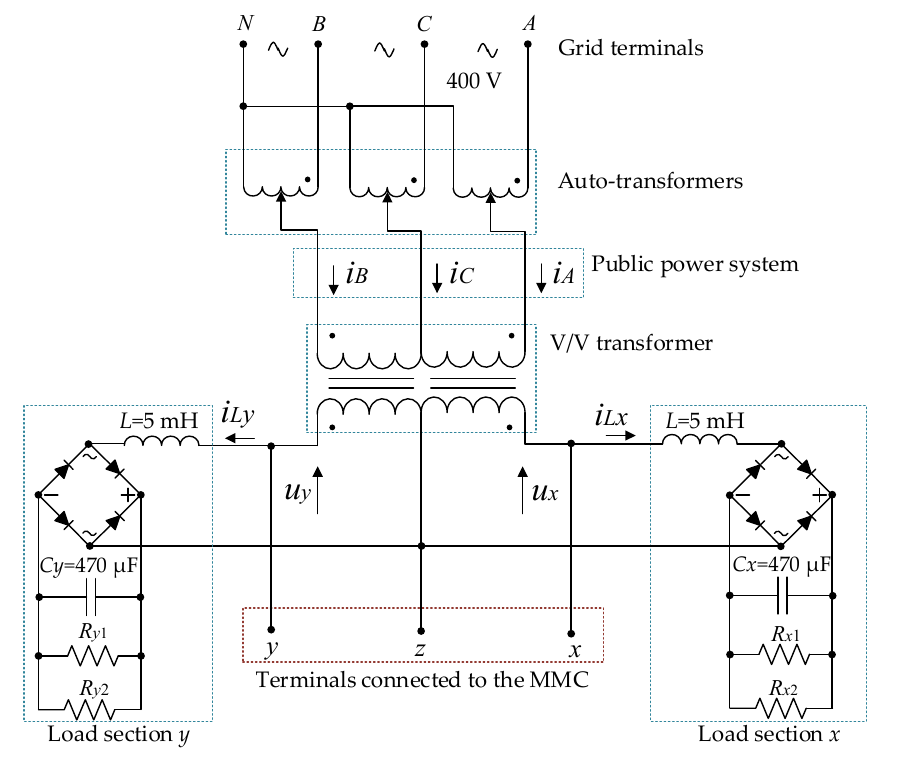
Figure 6. Supplementary power equipment diagram.